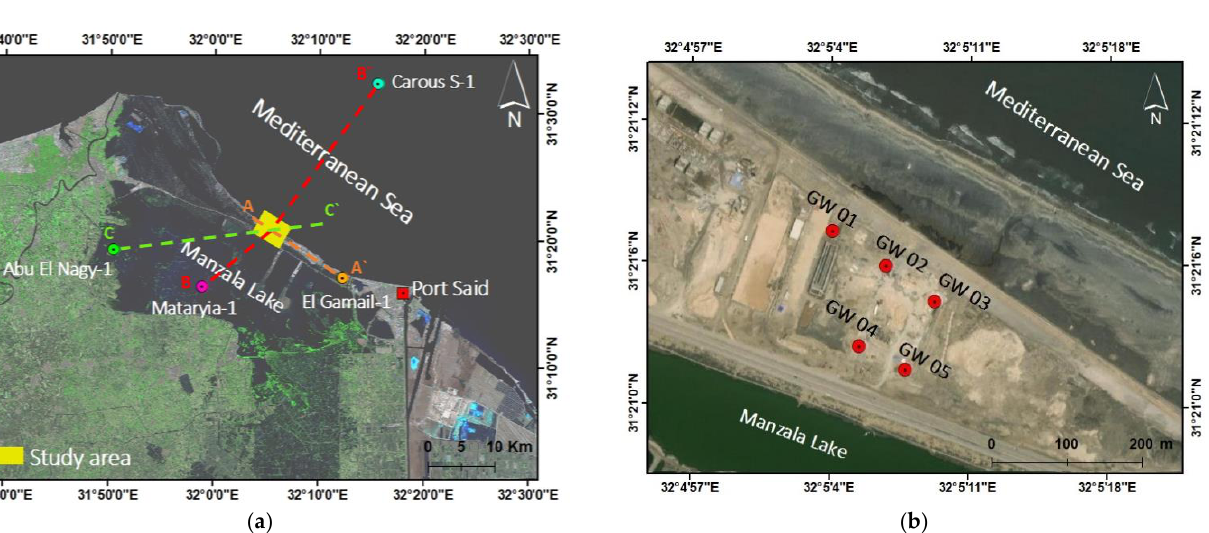
Figure 2. ( a ) Monthly average rainfall. ( b ) Average annual rainfall amount (mm) and rainy days during the period 2009 – 2021 for Port Said [64].